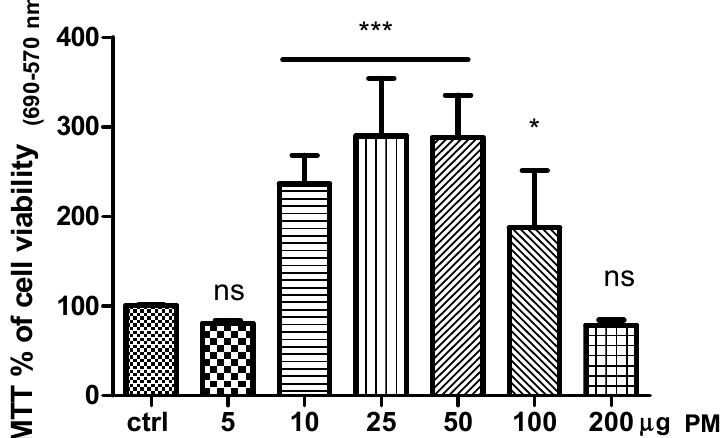
Figure 1. Dose response of phytomelatonin (PM) in human keratinocytes cell viability. A significant increase of the cell vitality was appreciated when exposed to PM in the range between 10 to 50 µ g (*** P < 0.0001) and at 100 µ g (* P < 0.05) compared to the control (DMSO-vehicle).